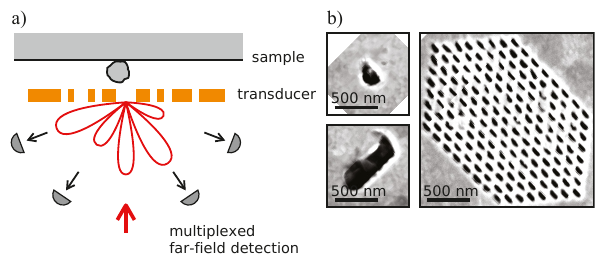
Figure 1: (a) A complex nanophotonic structure scatters incident light into many degrees of freedom in the far field. These contain rich subwavelength information on a sample positioned in the near field of the structure, which functions as a near-field transducer. A multiplexed readout of these degrees of freedom may enable rapid nanoscale sensing without the translation of the transducer. (b) SEM images of the near-field transducers used in this work, which consist of one or more apertures in a gold